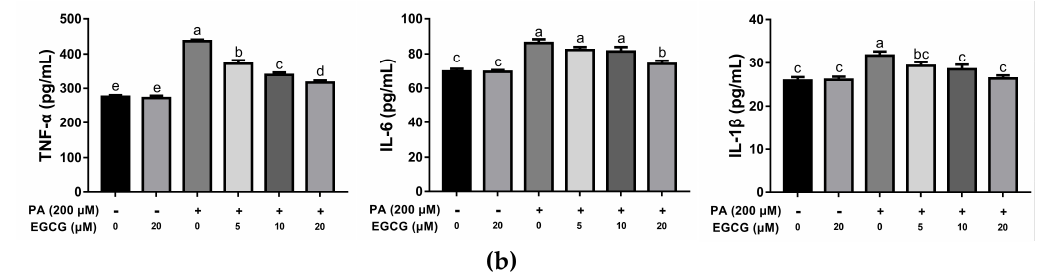
Figure 1. E ff ects of ( − )-epigallocatechin gallate (EGCG) on lipid accumulation and inflammatory responses of PA-stimulated BV-2 cells. BV2 cells were pretreated with di ff erent dosages of EGCG (EL: low concentration of EGCG (5 µ M), EM: medium concentration of EGCG (10 µ M), EH: high concentration of EGCG (20 µ M)) for 2 h and then stimulated with 200 µ M palmitic acid (PA) for 24 h. ( a ) Lipid distribution in BV-2 cells was observed by oil red O staining and analyzed with ImageJ; lipids were stained red; ( b ) Levels of TNF- α , IL-6, and IL-1 β in the conditioned medium were measured by ELISA. Data are means ± SEM of three independent experiments performed in triplicate. Di ff erent superscript letters indicate significantly di ff erent means at p < 0.05 (a > b > c > d).